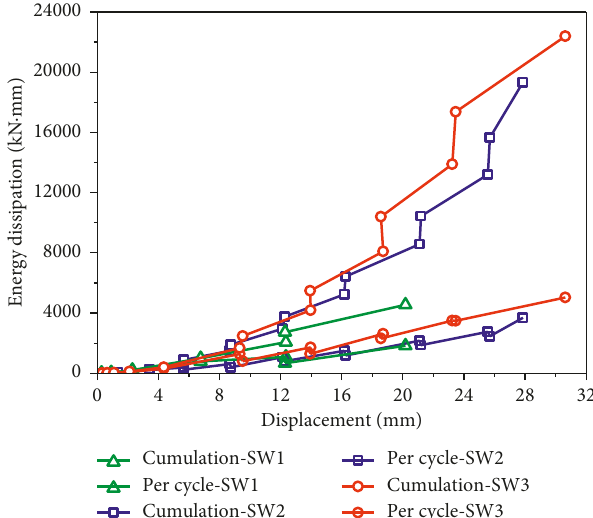
Figure 17: Energy dissipation of the specimens.